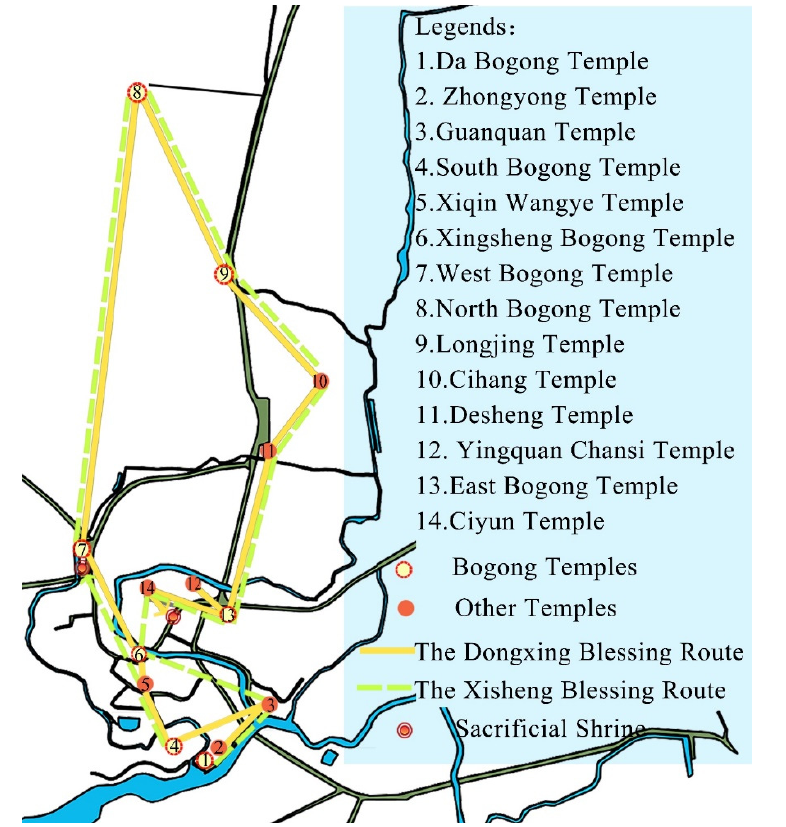
Figure 7. Route and Scope of Blessing Rites in Dongxing and Xisheng of Wugoushui. (Source: plotted based on [61] and field investigation.) based on [61] and field